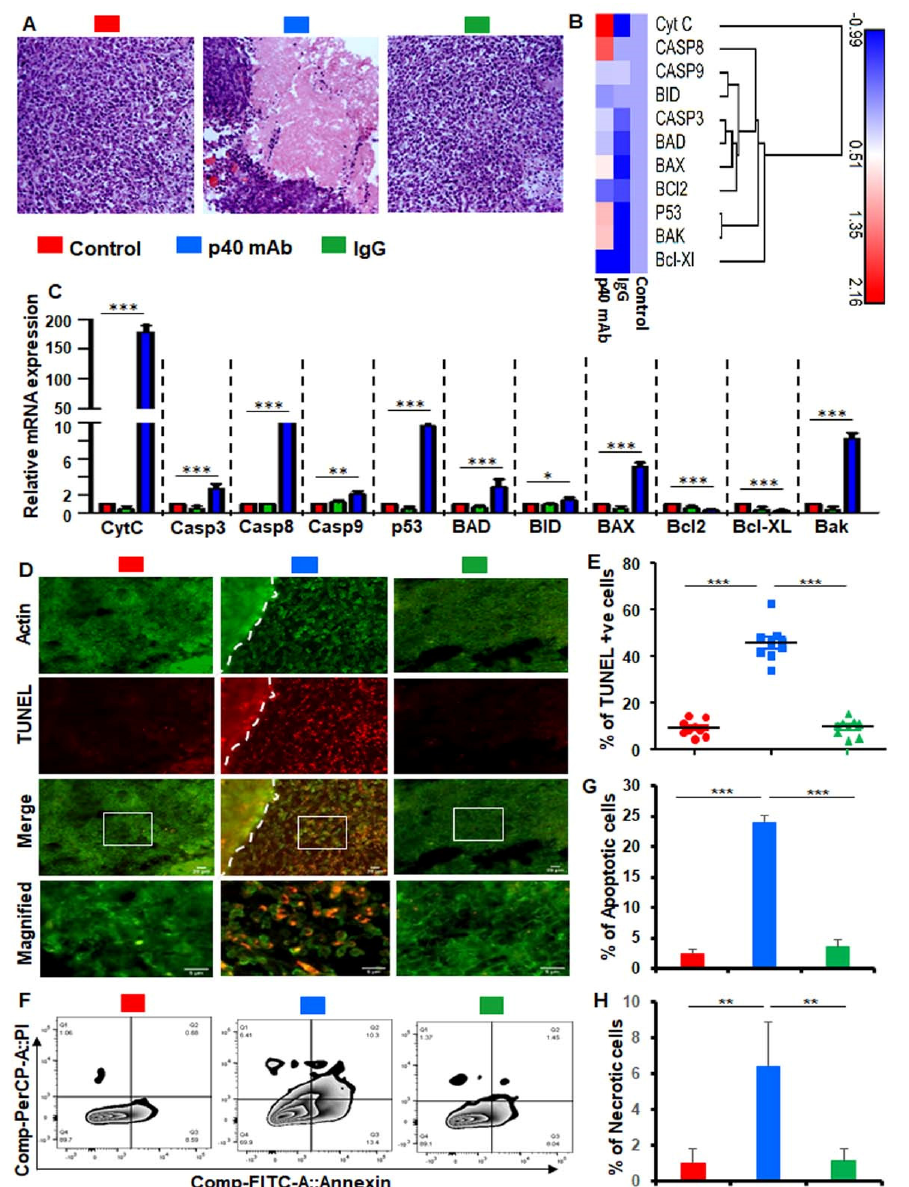
Figure 4. Stimulation of death response in TNBC tumor of PDX mice by p40 mAb. Female 6–8 week old NSG mice were engrafted TNBC tumor in the flank. After about 4 weeks of engraftment, when tumors of PDX mice ( n = 5 per group) were 0.6–0.8 cm 2 in size, mice were treated with p40 mAb and hamster IgG at a dose of 2 mg/kg body wt once a week. After 2 weeks of treatment, H&E staining ( A ) was performed on tumor sections. Tumor tissues were analyzed for the expression of different death-related genes by a custom mRNA array ( B ), which was then plotted with heat map explorer software. ( C ) Real-time mRNA analyses of 11 different death-related genes. Results are mean ± SEM of five mice. *** p < 0.001. Tumor tissue sections were double-labeled for actin and TUNEL ( D ) followed by counting of TUNEL-positive cells in two sections of each of five mice per group ( E ). Single-cell suspensions isolated from tumor tissues were studied by dual FACS for propidium iodide (PI) and Annexin V ( F ) in the LSRFortessa analyzer (BD Biosciences) followed by analysis using the FlowJo Software (v10). Quantification of apoptotic (PI − Annexin V + early apoptotic + PI + Annexin V + late apoptotic; G ) and necrotic (Annexin V − PI + ; H ) cells. Results are mean ± SEM of three PDX mice per group. * p < 0.05; ** p < 0.01; *** p <